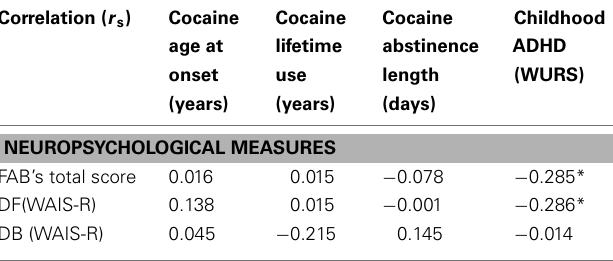
Table 4 | Correlation between drug use variables, childhoodADHD, and neuropsychological measures among the CDI and CDI +